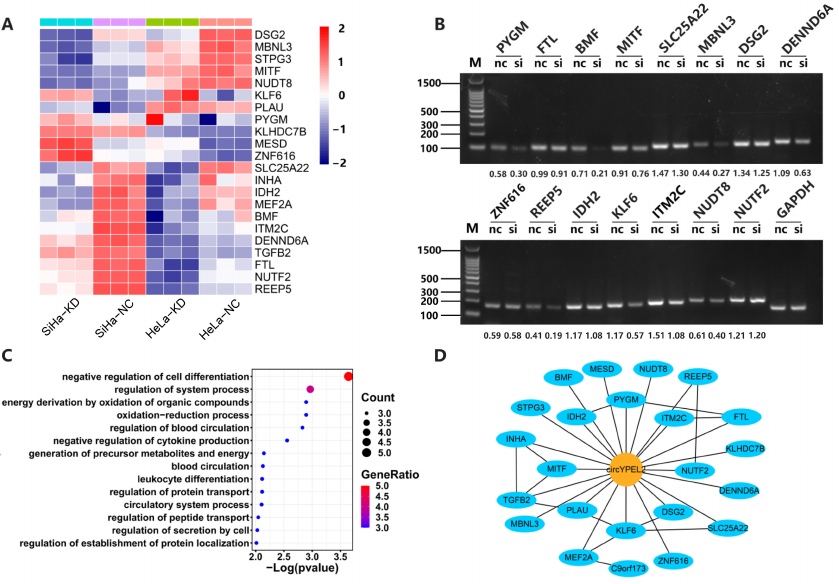
Figure 5. CircYPEL2 may regulate CC via downstream gene. ( A ) Clustering analysis of genes with significantly different expression in two cell lines treated with si-NC and si-circYPEL2 (|log2FoldChange| > 1, adjusted p- value < 0.05). TPM of genes were used for depicting the heatmap. ( B ) RT-PCR validation of differentially expressed genes. The nc represents si-NC and si repre- sents si-circYPEL2. ( C ) Gene Ontology analysis of differentially expressed genes. ( D ) Regulatory network of circRNAs and coding genes. The blue and yellow nodes represent coding genes and circRNA,